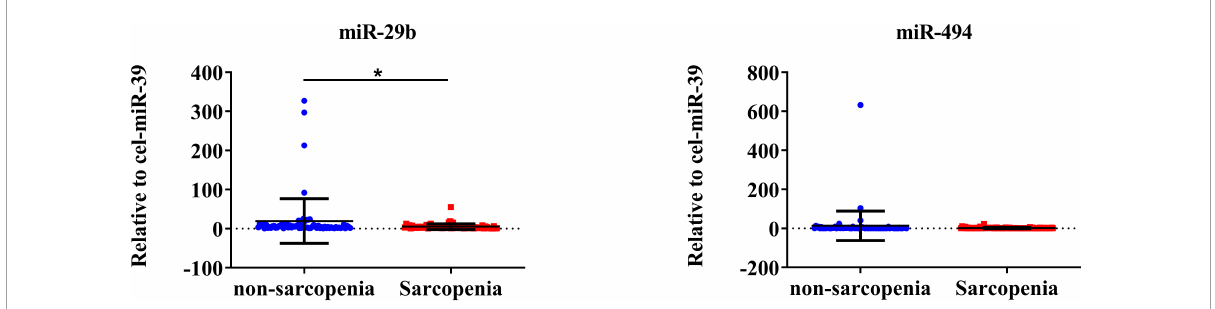
FIGURE3 CVRF-associated circulating miR-29b decrease in response to sarcopenia in the elderly. The expression level of miRNAs was normalized using spike-in cel-miR-39; unpaired T -test was used for these data; *compared to non-sarcopenia of the elderly; * P < 0.05; n = 73.